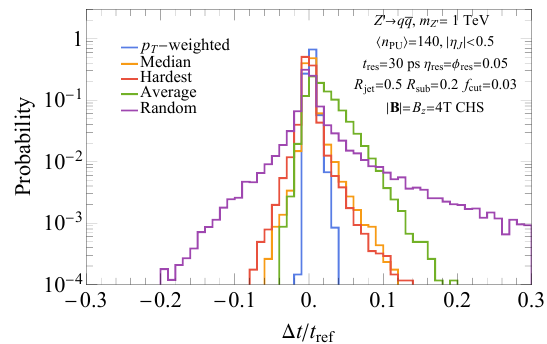
Figure 15 . The relative time difference distribution for | η J | < 0 . 5 with pileup, charged hadron subtraction, and trimming. This can be compared with figure 14